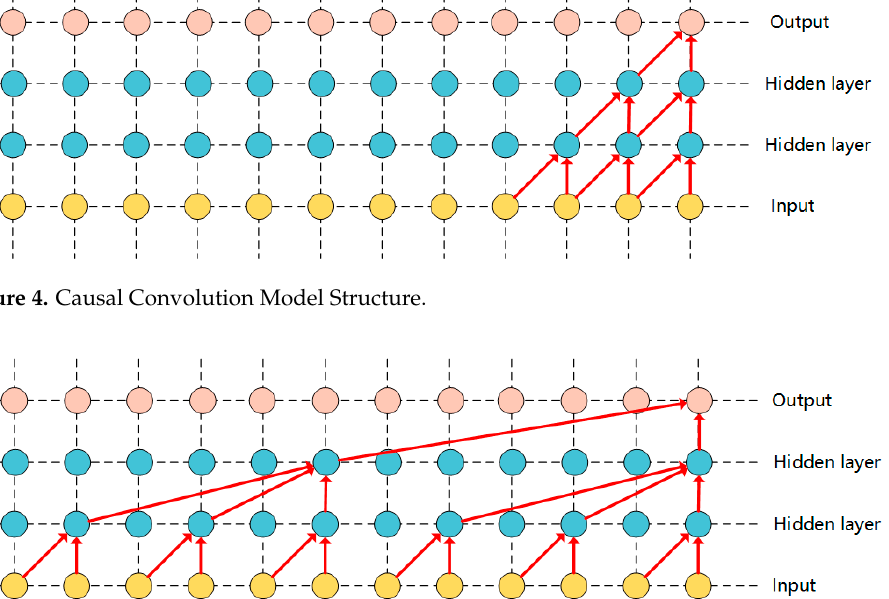
Figure 3. Audio classification results.